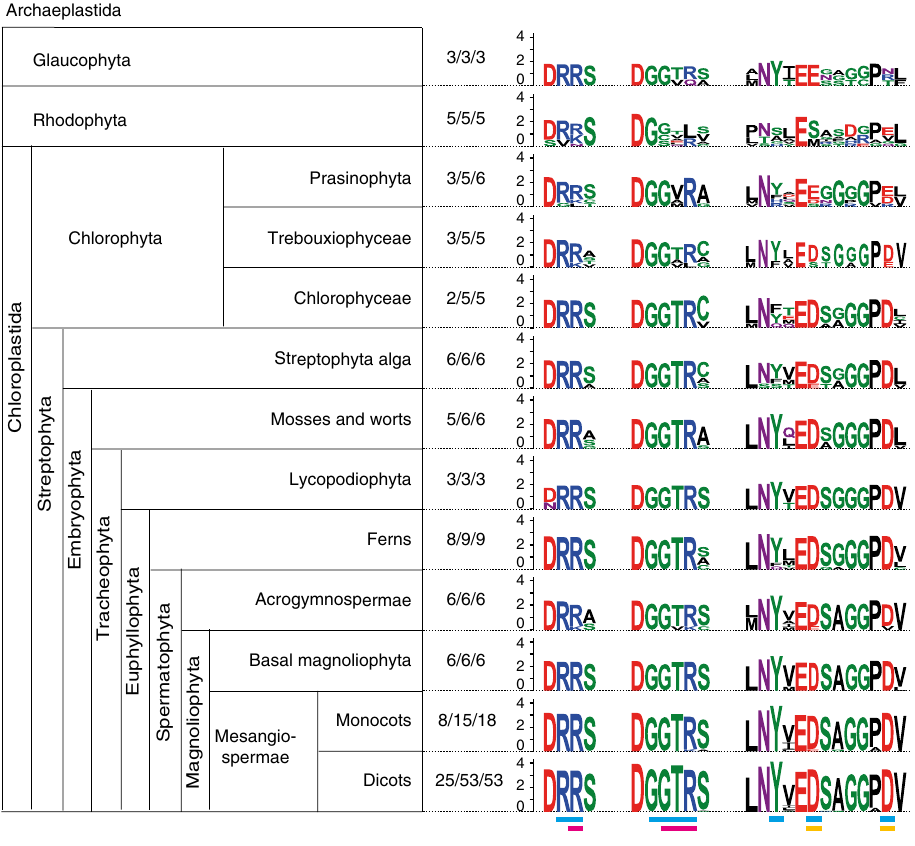
Fig. 7 Conservation across the green lineage of amino acids critical for RRP41 activity. Sequence logos expressed in bits were calculated from sequence alignments of RRP41 orthologues from all divisions of Archaeplastida. The number of order/families/sequences used for each alignment is indicated. The bars below the sequence logos indicate amino acids involved in RNA binding (blue), Pi coordination (magenta) and Mg 2+ coordination